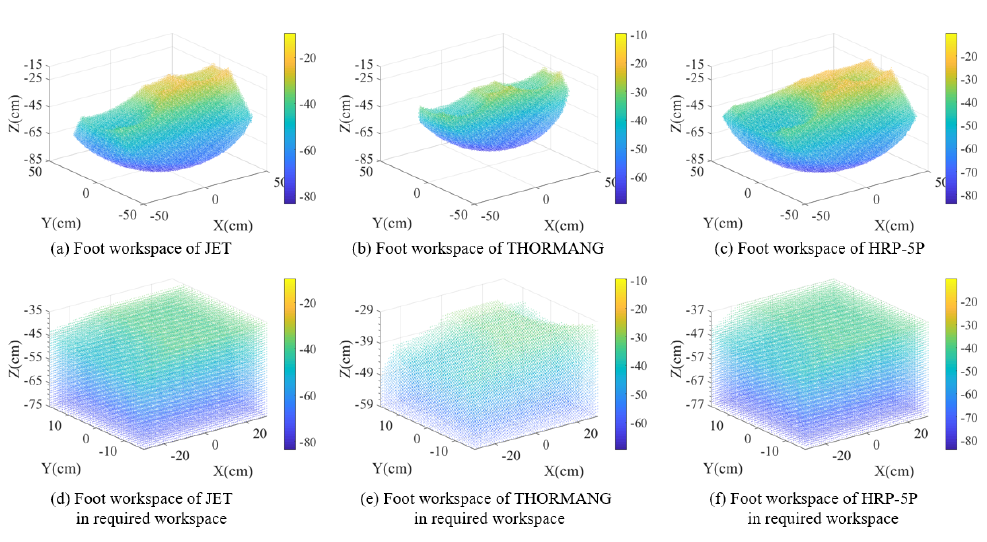
Figure 11. Comparison of foot workspace among JET, THORMANG, and HRP-5P. ( a – c ) are the total foot workspaces of JET, THORMANG, and HRP-5P. ( d – f ) are the required workspaces with 60 cm × 34 cm on x- and